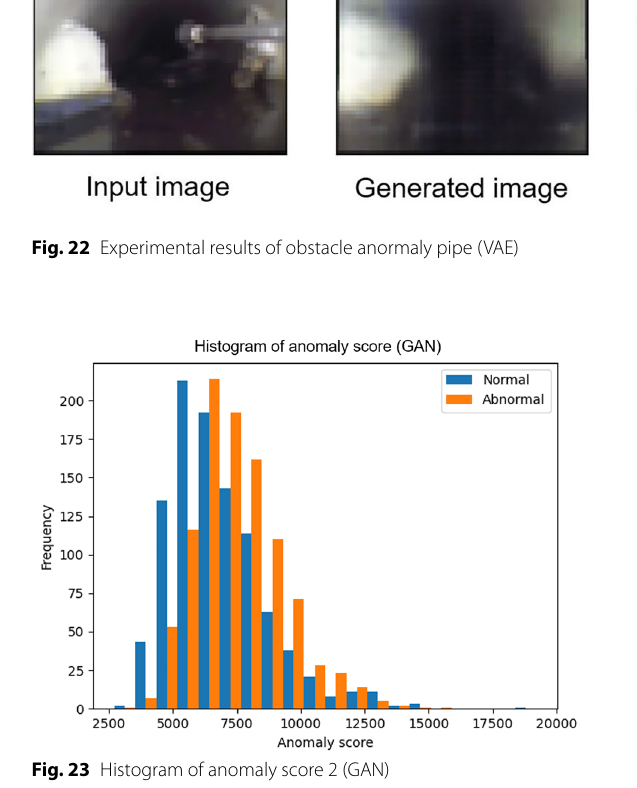
Fig. 24 Histogram of anomaly score 2